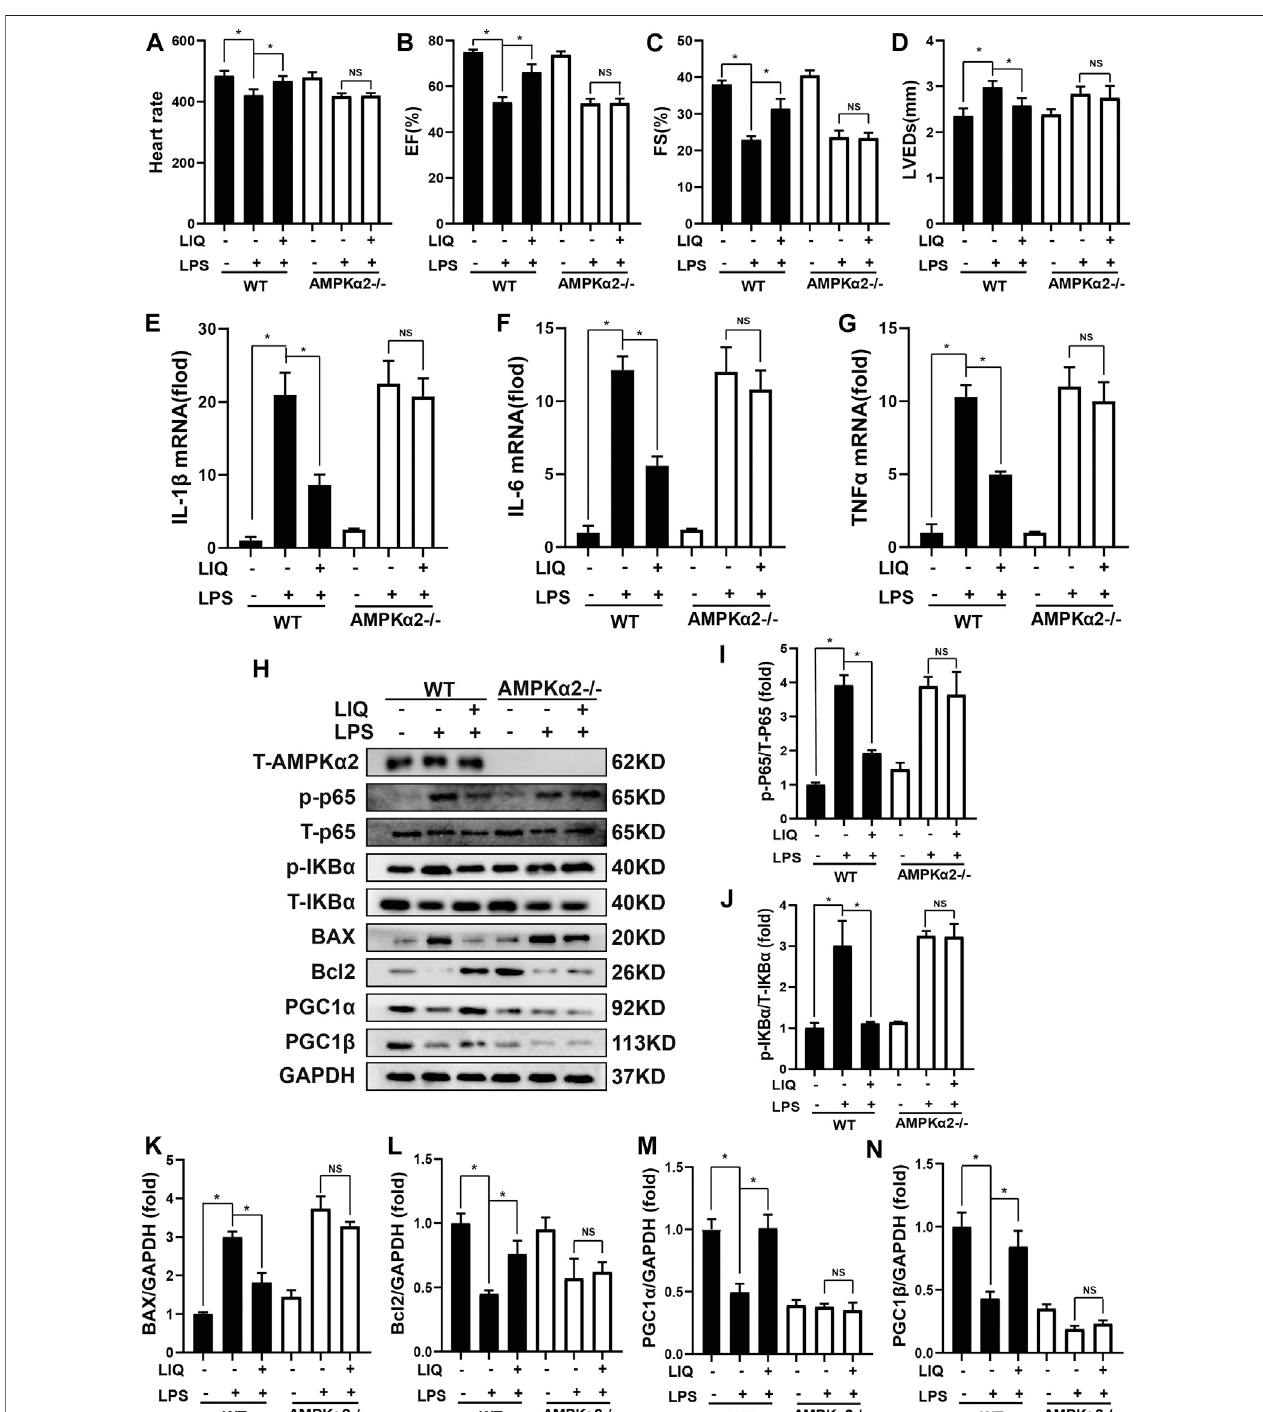
FIGURE 6 | LIQ treatment could not prevent LPS-induced mouse heart injuries after AMPK α 2 knockout Echocardiography was performed to analyze (A) Heart rate, (B) left ventricleejectionfraction(EF), (C) leftventricular fractional shortening (FS) (D) leftventricularend-systolic diameter(LVEDs)( n (cid:2) 12).RT-PCRwasperformed to detect the mRNA expression of (E) IL-1 β , (F) IL-6 and (G) TNF α ( n (cid:2) 6), all of mRNAs expression were normalized to GAPDH before the relative quantitative analysis, (H) Representative western-blots of T-AMPK α 2, p-P65, T-P65, p-I κ B α , T-I κ B α , BAX, Bcl2, PGC1 α , PGC1 β and GAPDH ( n (cid:2) 6), relative quantitative analysis proteins expression of (I) p-P65/T-P65, (J) p-I κ B α /T-I κ B α , (K) BAX/GAPDH, (L) Bcl2/GAPDH, (M) PGC1 α /GAPDH and (N) PGC1 β /GAPDH, all proteins were normalizedtoGAPDHbeforethequantitativeanalysis( n (cid:2) 6).AMPK α 2knockoutmicewerepretreatedwithLIQ(80 mg/kg/d)for7 daysandthenwereinjectedwithLPS (10 mg/kg) for 12 h before these experiments. * p < 0.05 compared with the indicated group, the data were expressed as the Mean ± SEM and were compared by one- way ANOVA with Tukey post hoc analysis.